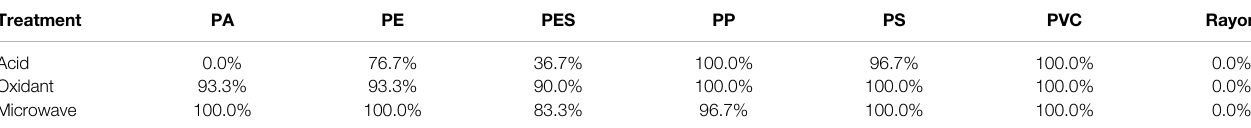
TABLE 2 | Recovery rate of reference polymers under acid, oxidant and microwave assisted oxidant treatment (PA — polyamide, PE — polyethylene, PES — polyester, PP — polypropylene, PS — polystyrene, PVC — polyvinyl chloride). Treatment